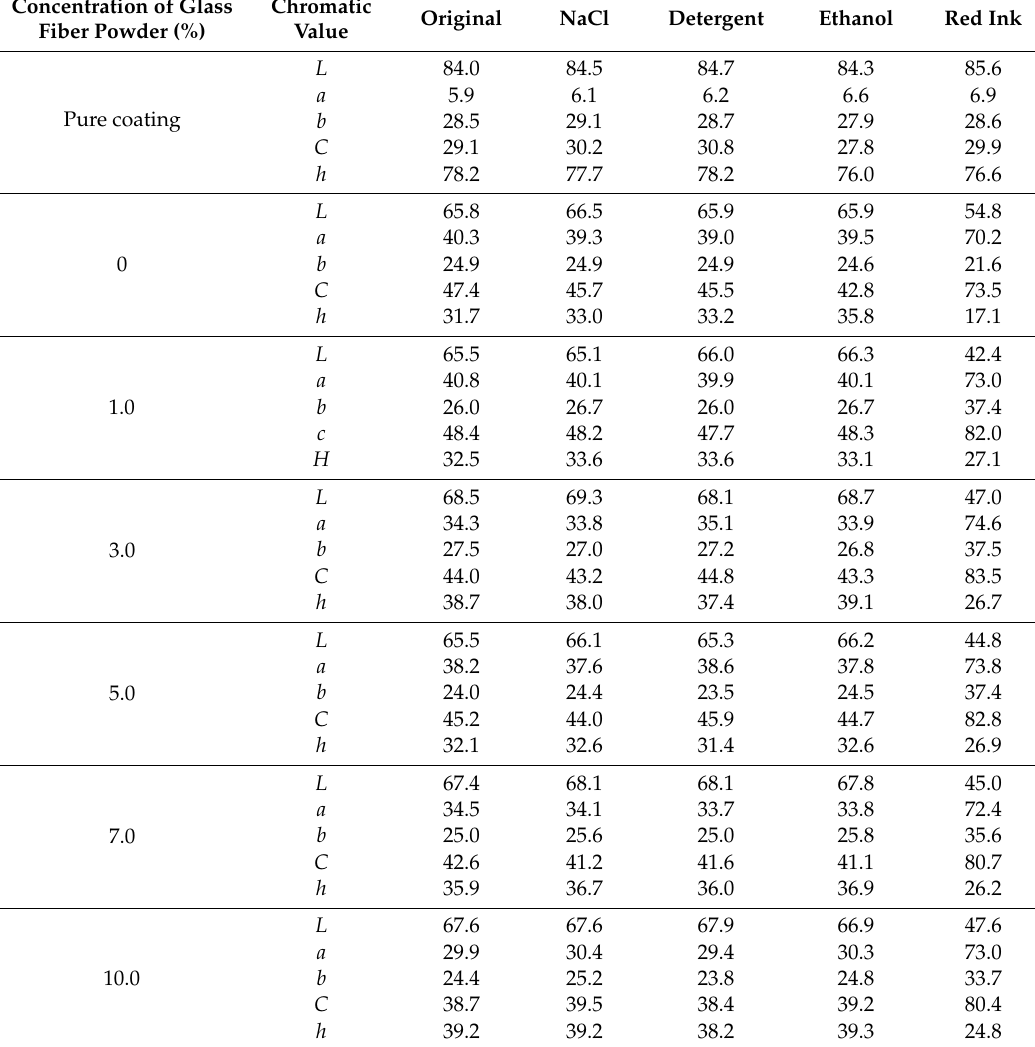
Table 6. The chromatic value of waterborne coatings after liquid resistance